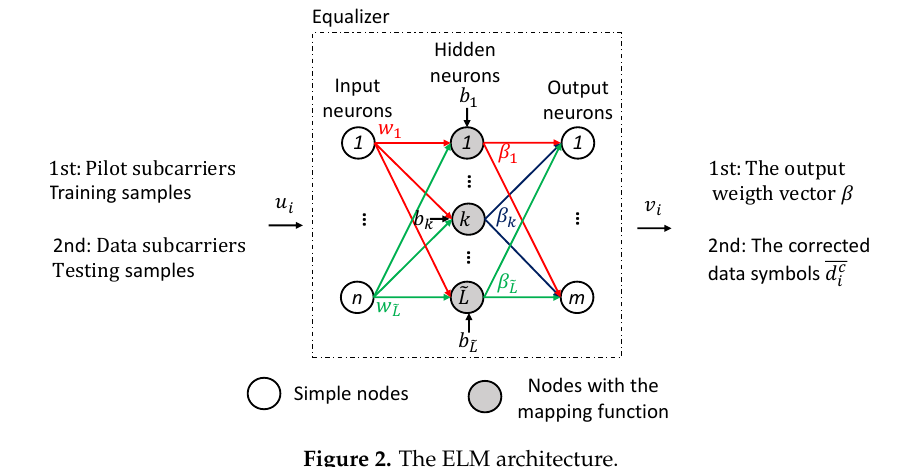
Figure 2. The ELM